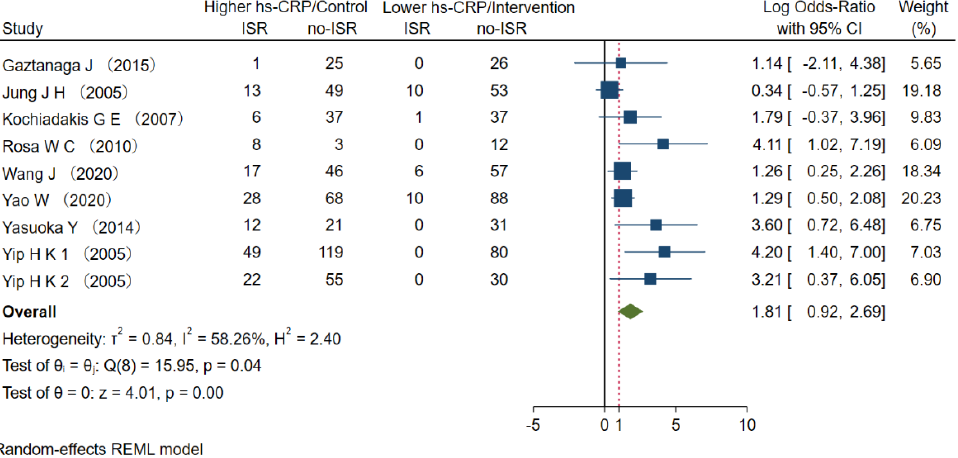
Figure 2. Meta analysis of ORs in studies evaluating the prognostic value of hs-CRP to restenosis in higher vs lower hs-CRP group. OR: odds ratio, hs-CRP: high-sensitive C-reactive protein, ISR: in-stent restenosis [21–29].